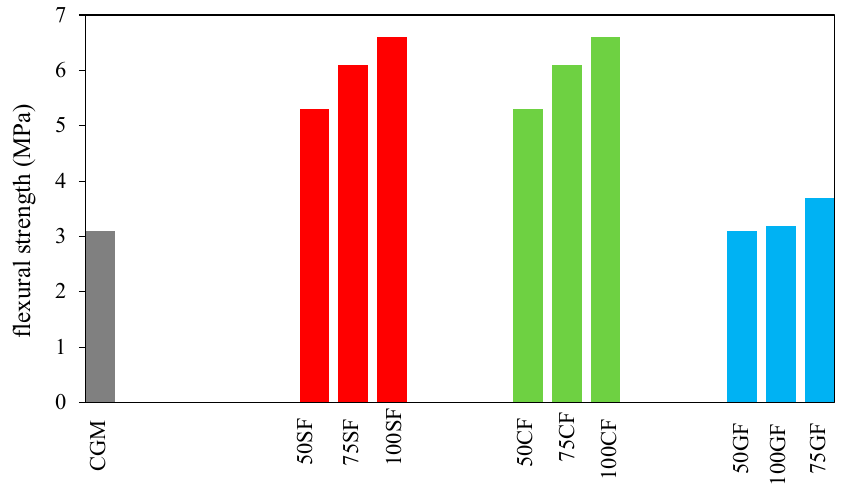
Figure 13. Flexural strength of GPM [55].